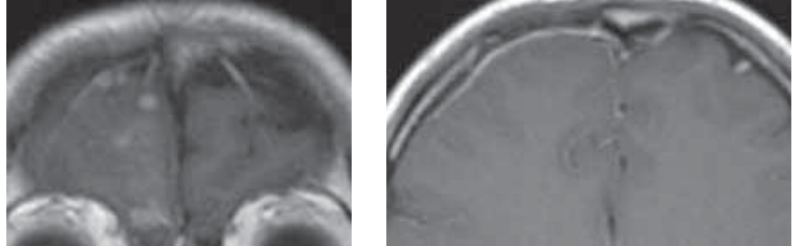
FIGURE 5 and 6. The coronal and axial contrast-enhanced T1-weighted images show a right frontal heterogeneously enhanced mass, with linear enhancement of the adjacent dura, which is better visualised on an axial image.